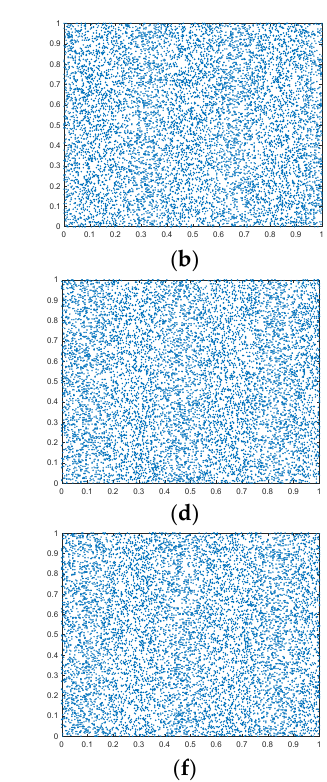
Figure 9. Correlation analysis. ( a ) The horizontal direction of the plaintext; ( b ) The horizontal direction of the ciphertext; ( c ) The vertical direction of the plaintext; ( d ) The vertical direction of the ciphertext; ( e ) The diagonal direction of the plaintext; ( f ) The diagonal direction of the ciphertext. The correlation coefficients of all original images are close to 1, while the encrypted images are close to 0 in Table 5, indicating that the scheme is good and can effectively resist statistical attacks. Table 5. Correlation coefficient.